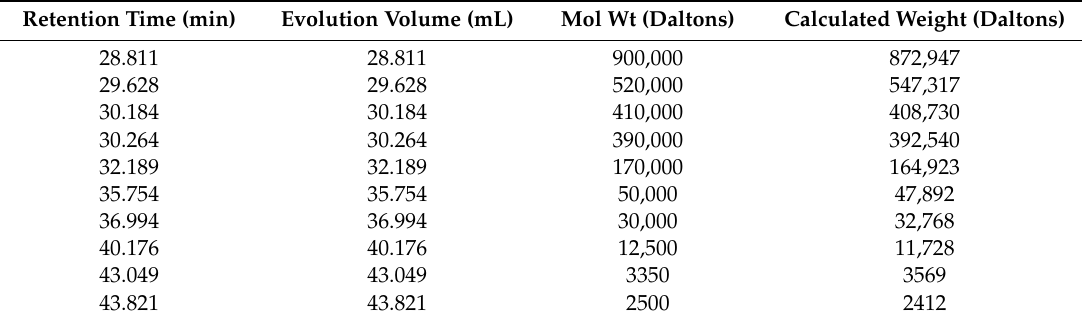
Figure 7. Gel permeated chromatography (GPC) traces of the PMMA (core) polymer. Table 2. Tabulated values of the PMMA core polymer GPC measurement.